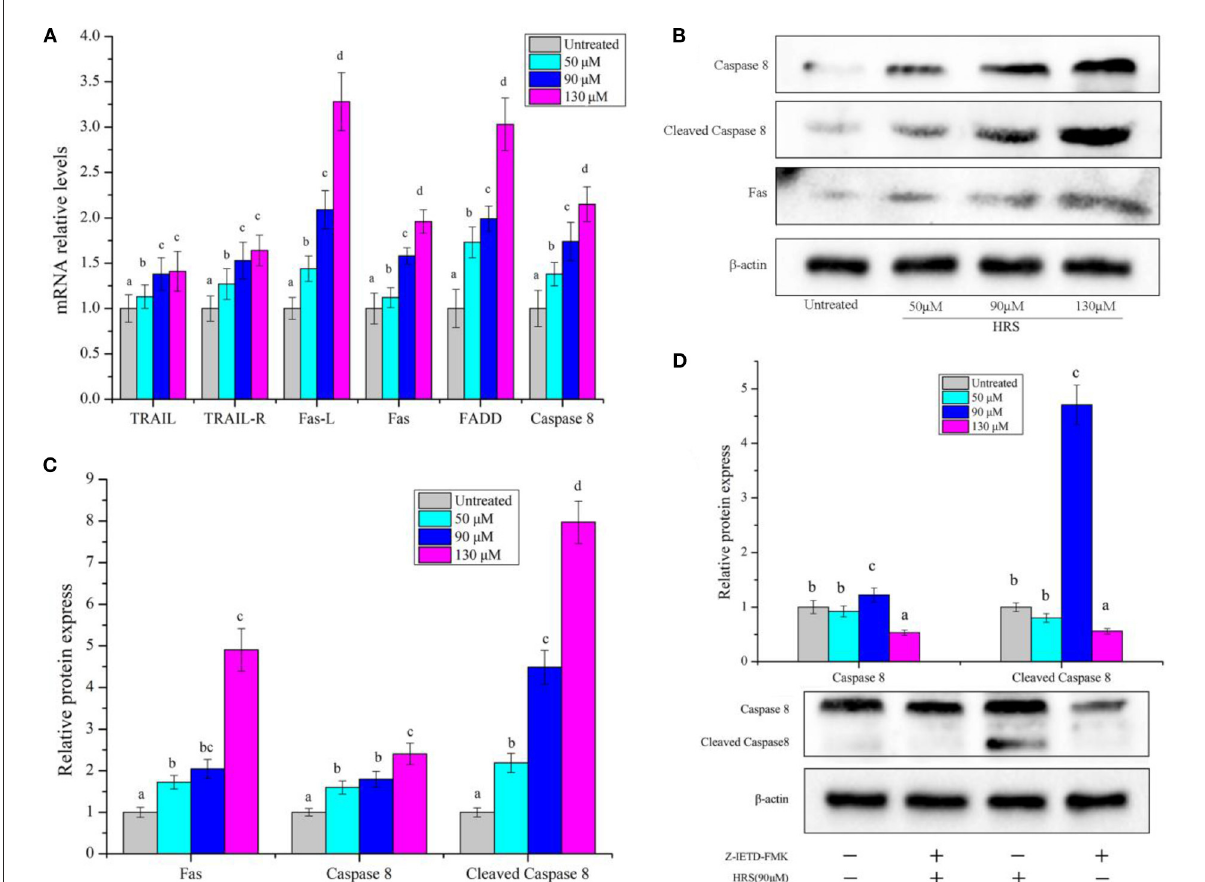
FIGURE9 The mRNA level of death receptor pathway genes and protein in HCT-116 cells treated with hydroxy- γ -sanshool (HRS). (A) The mRNA level of genes in HCT-116 cells. (B) Western blot analyses of related genes. (C) Relative protein expression of related genes. (D) Protein level of Caspase 8 in HCT-116 cells, with or without an inhibitor (Z-IETD-FMK). HCT-116 cells were treated with HRS at designated concentrations and compared to untreated cells. All data were expressed as means ± SD from three replicated experiments. a − d Within a cluster, columns without a common superscript differed ( p <